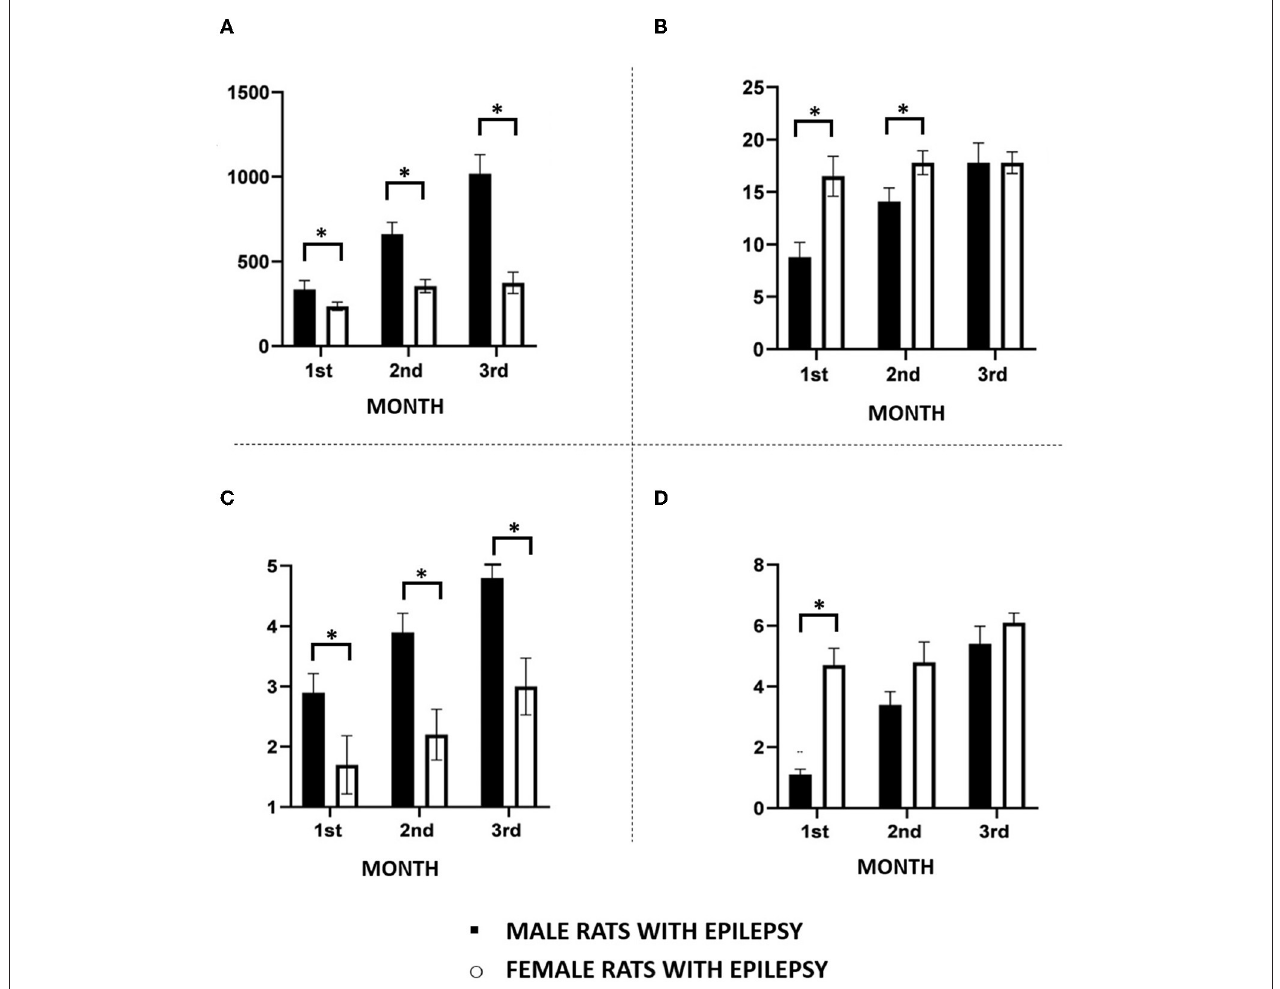
FIGURE 1 | Main features of spontaneous recurrent seizures observed in male and female rats during the chronic period of the pilocarpine model of epilepsy monitored continuously 24h for a period of 3 months. (A) Seizure duration; (B) Seizure frequency; (C) Seizure severity; (D) Seizure clusters. Data are expressed as mean ± SD. Data from male and female rats were compared using two-way ANOVA (multiple measures) followed by Sidak’s post-hoc test. * p <